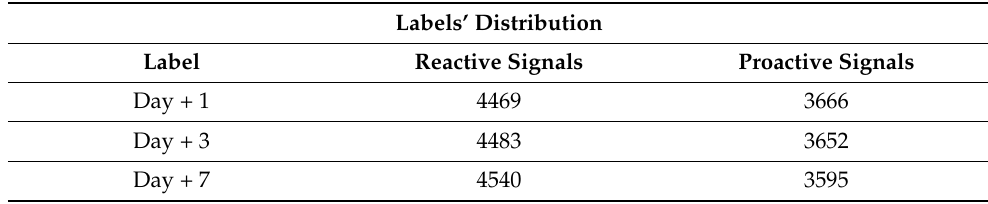
Table 1. Number of signals by type for each label.